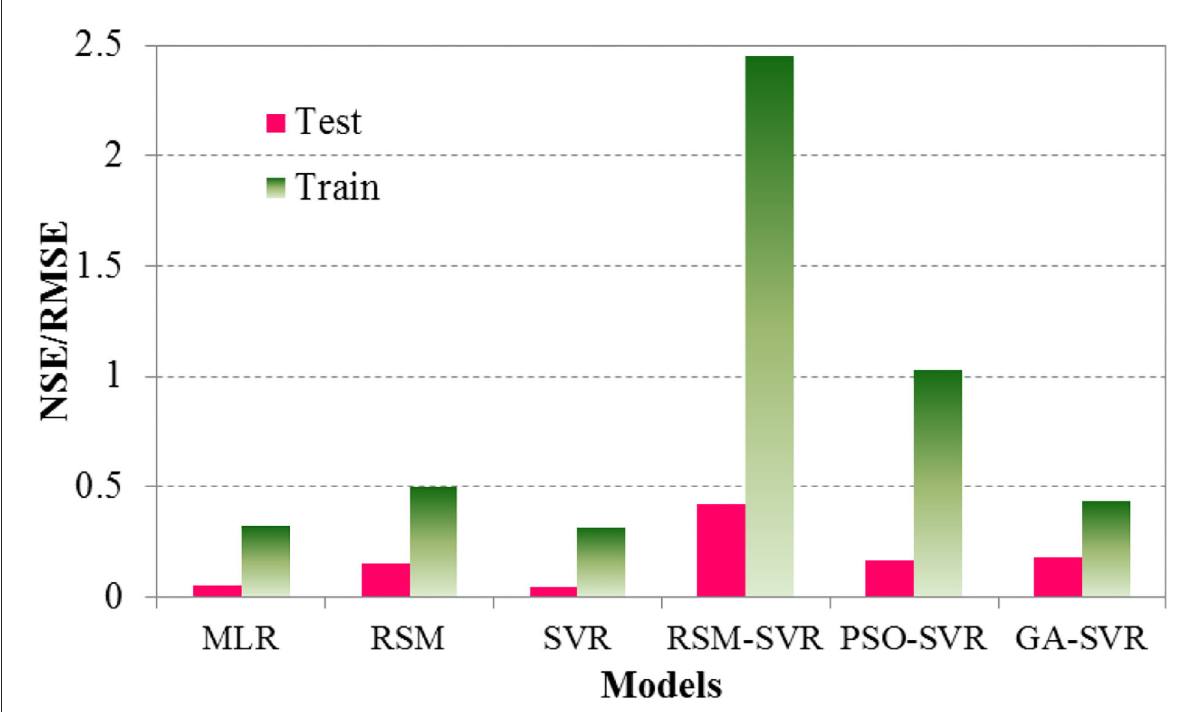
FIGURE7 NSE/RMSE factors for different models in the training and testing